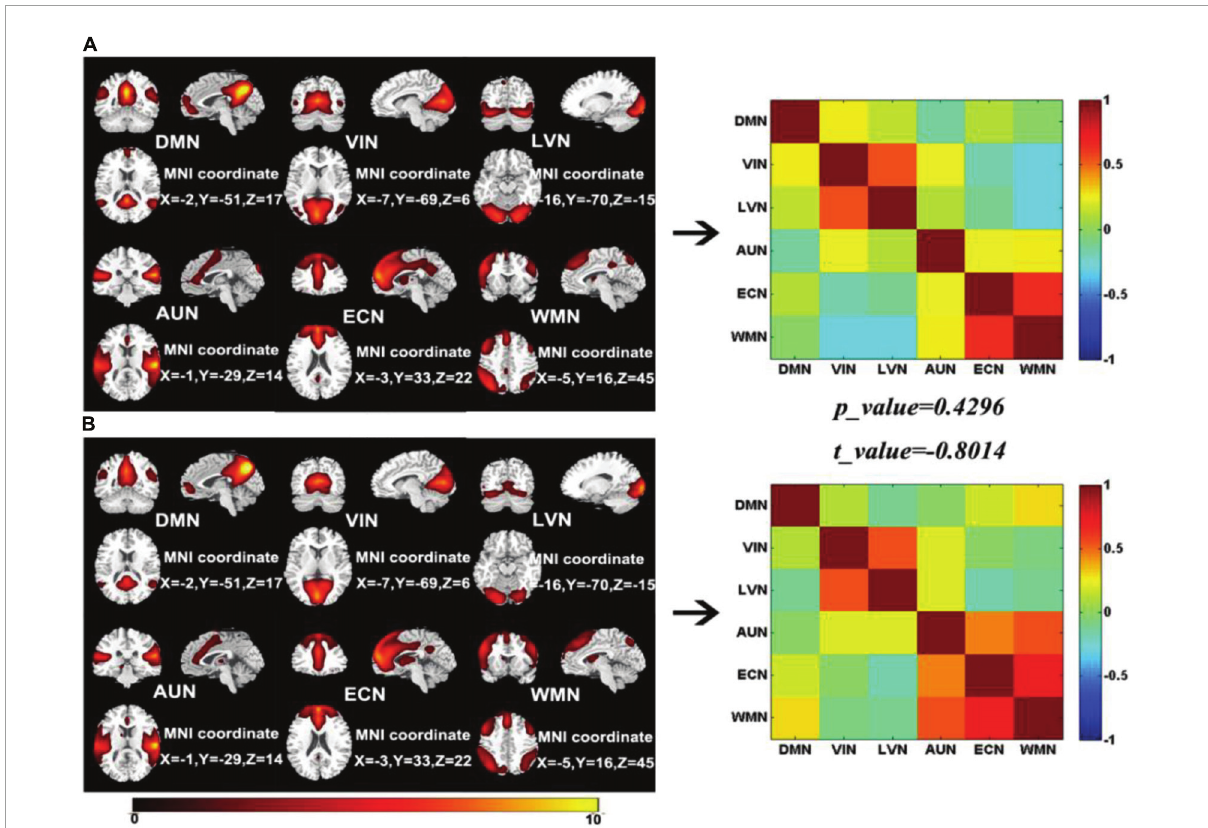
FIGURE1 Six resting-state brain functional networks for seafarer before and after sailing at the group level, included DMN, VIN, ECN, AUN, LVN, and WMN which were shown in (A,B) , respectively, as well as the SFC maps of the two groups corresponding to the six brain functional networks and the T statistical test results between